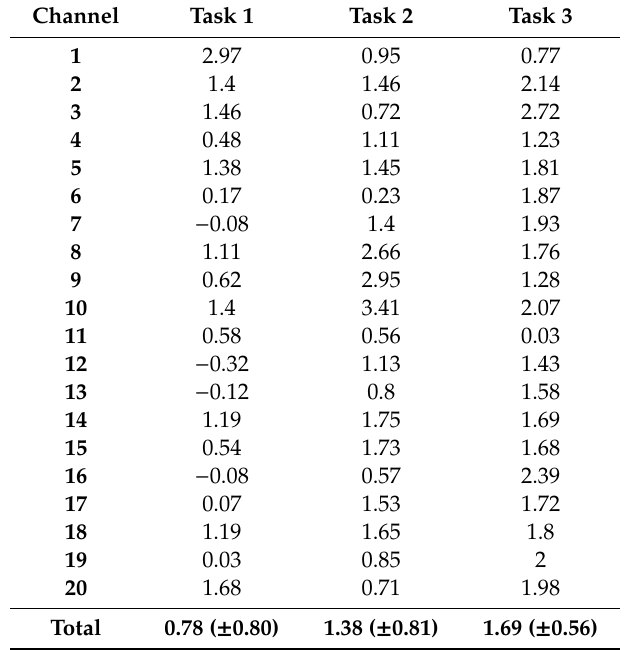
Table 20. t -Value s representing task activations according to channel.